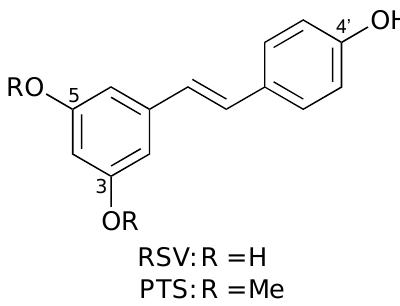
Figure 1. Chemical structures of RSV and PTS.